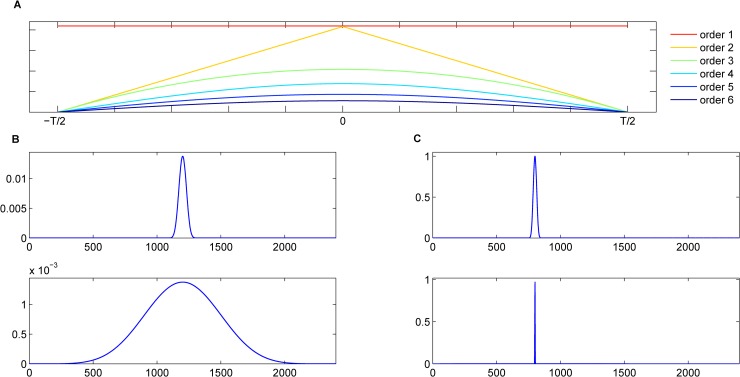
Examples of B-spline windows, and domain filter (order 6) with two different scales in the time and frequency domains.(A) Examples of B-spline windows; (B) Magnitude response of domain filter in the time domain; (C) Frequency response of domain filter.